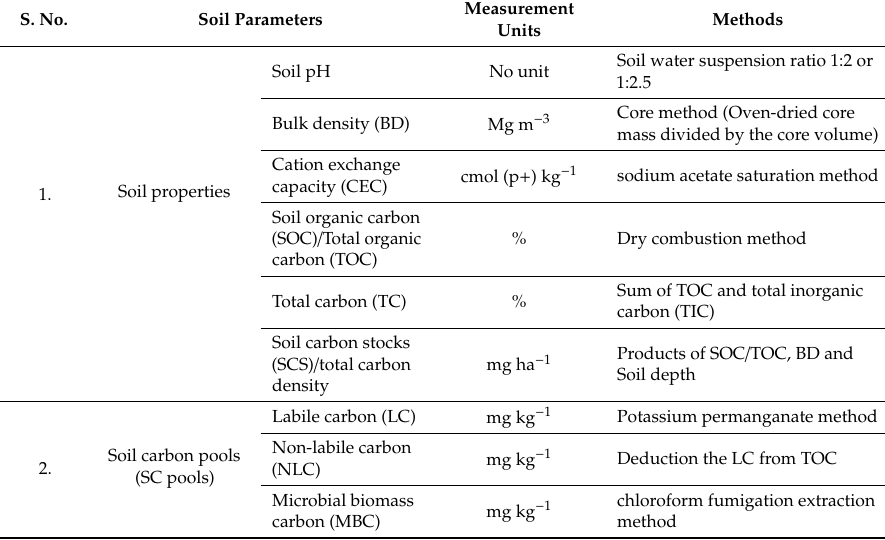
Table 2. Parameters used in this